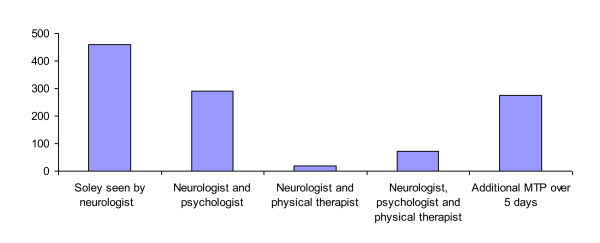
Allocation to different cobinations of consultation and additional MTP. MTP = Multidisciplinary treatment